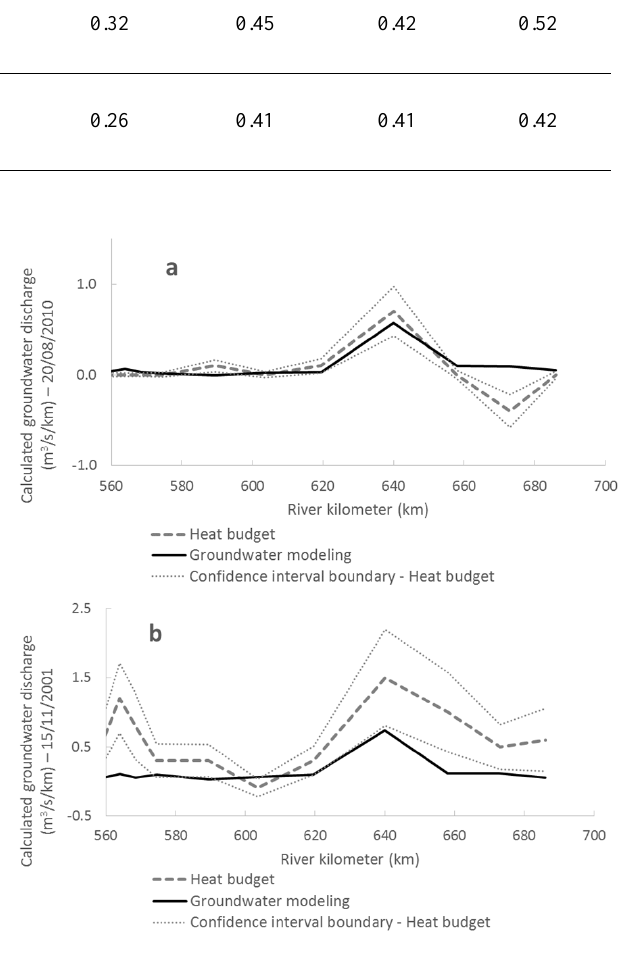
Figure 6. (a) Calculated groundwater discharge along the Loire River on 20 August 2010 using groundwater modeling and the heat budget. (b) Calculated groundwater discharge along the Loire River on 15 November 2001 using groundwater modeling and the heat